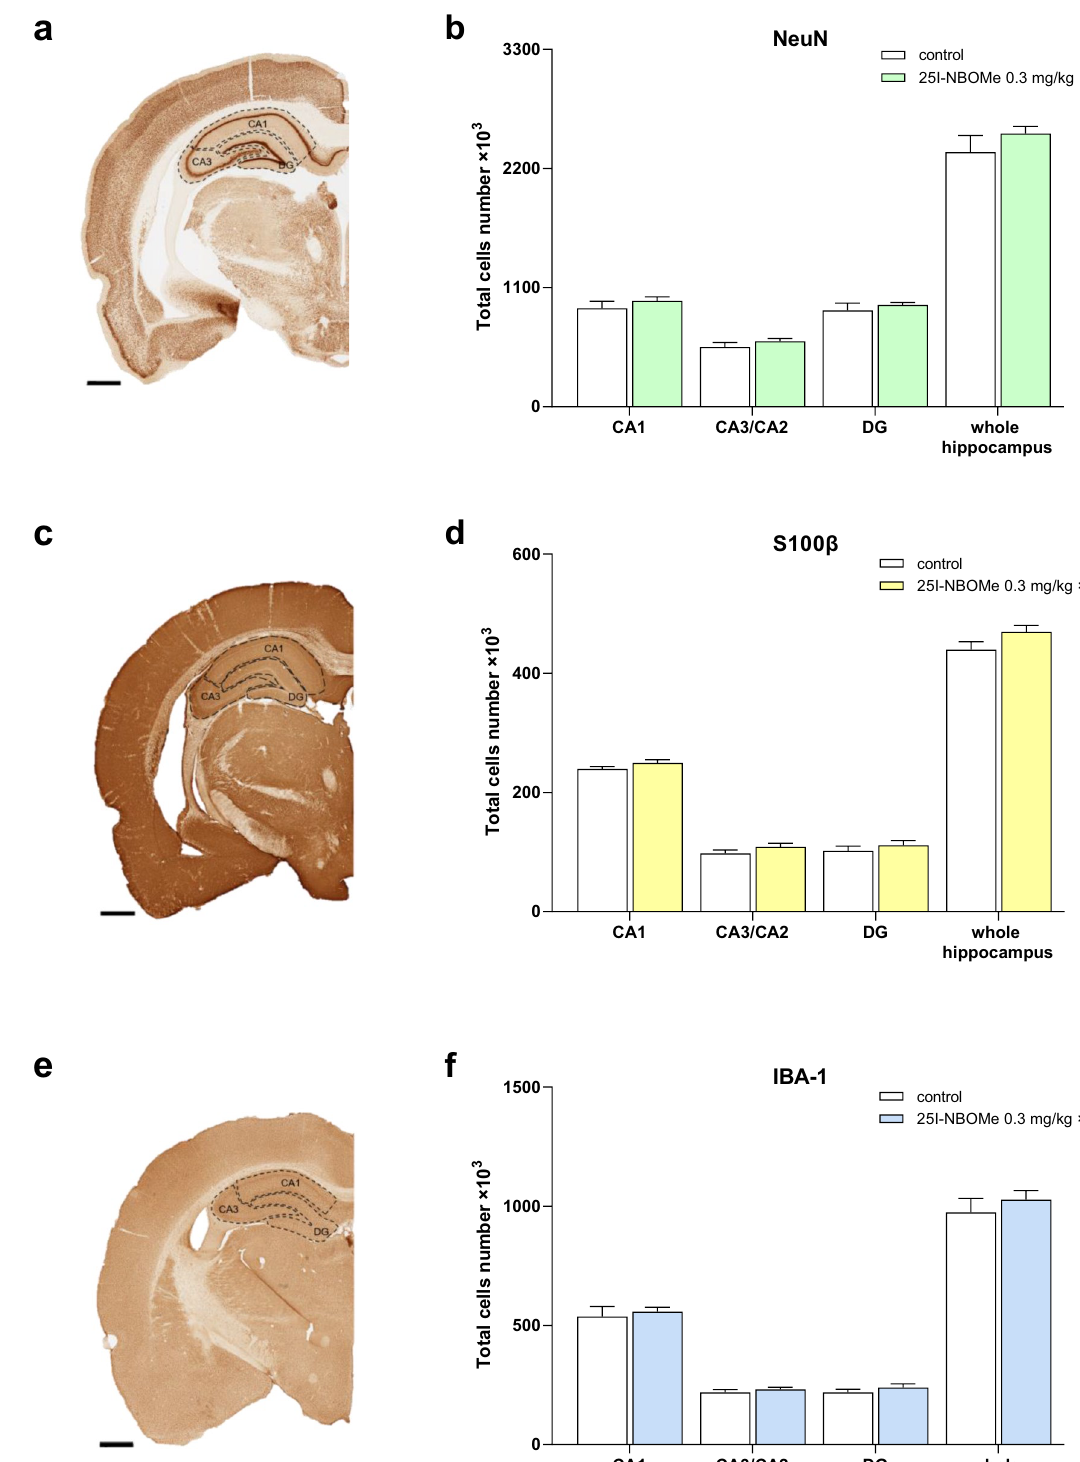
Figure 4. The number of neurons and glia cells in the subregions and in the entire hippocampus (n = 6 per group). The light photomicrographs that were immunoprobed for NeuN ( a ), S100β ( c ), IBA-1 ( e ) and examined for the number of immunopositive neurons ( b ), astrocytes ( d ), and microglia ( f ). The graph bars indicate the mean ± SEM. The scale bars represent 1 mm; DG dentate